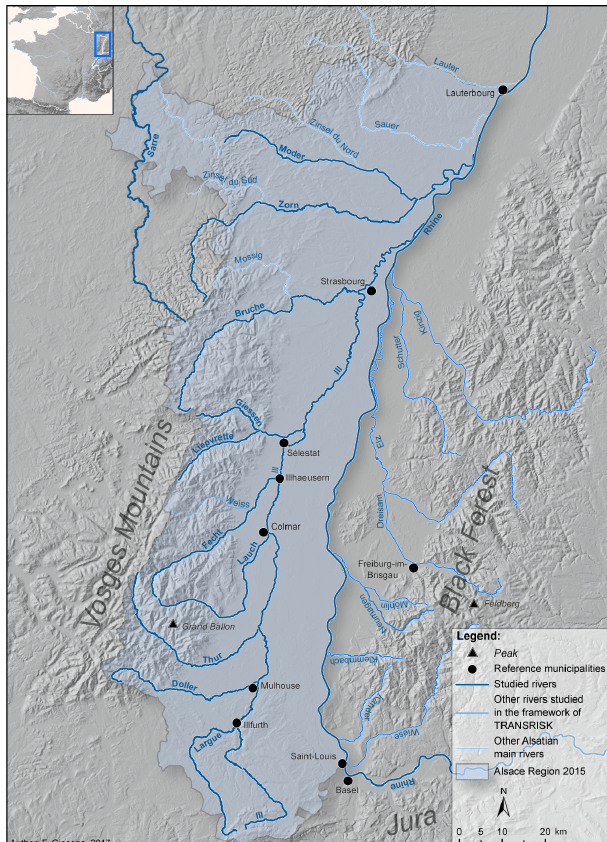
Figure 1. Presentation of the studied